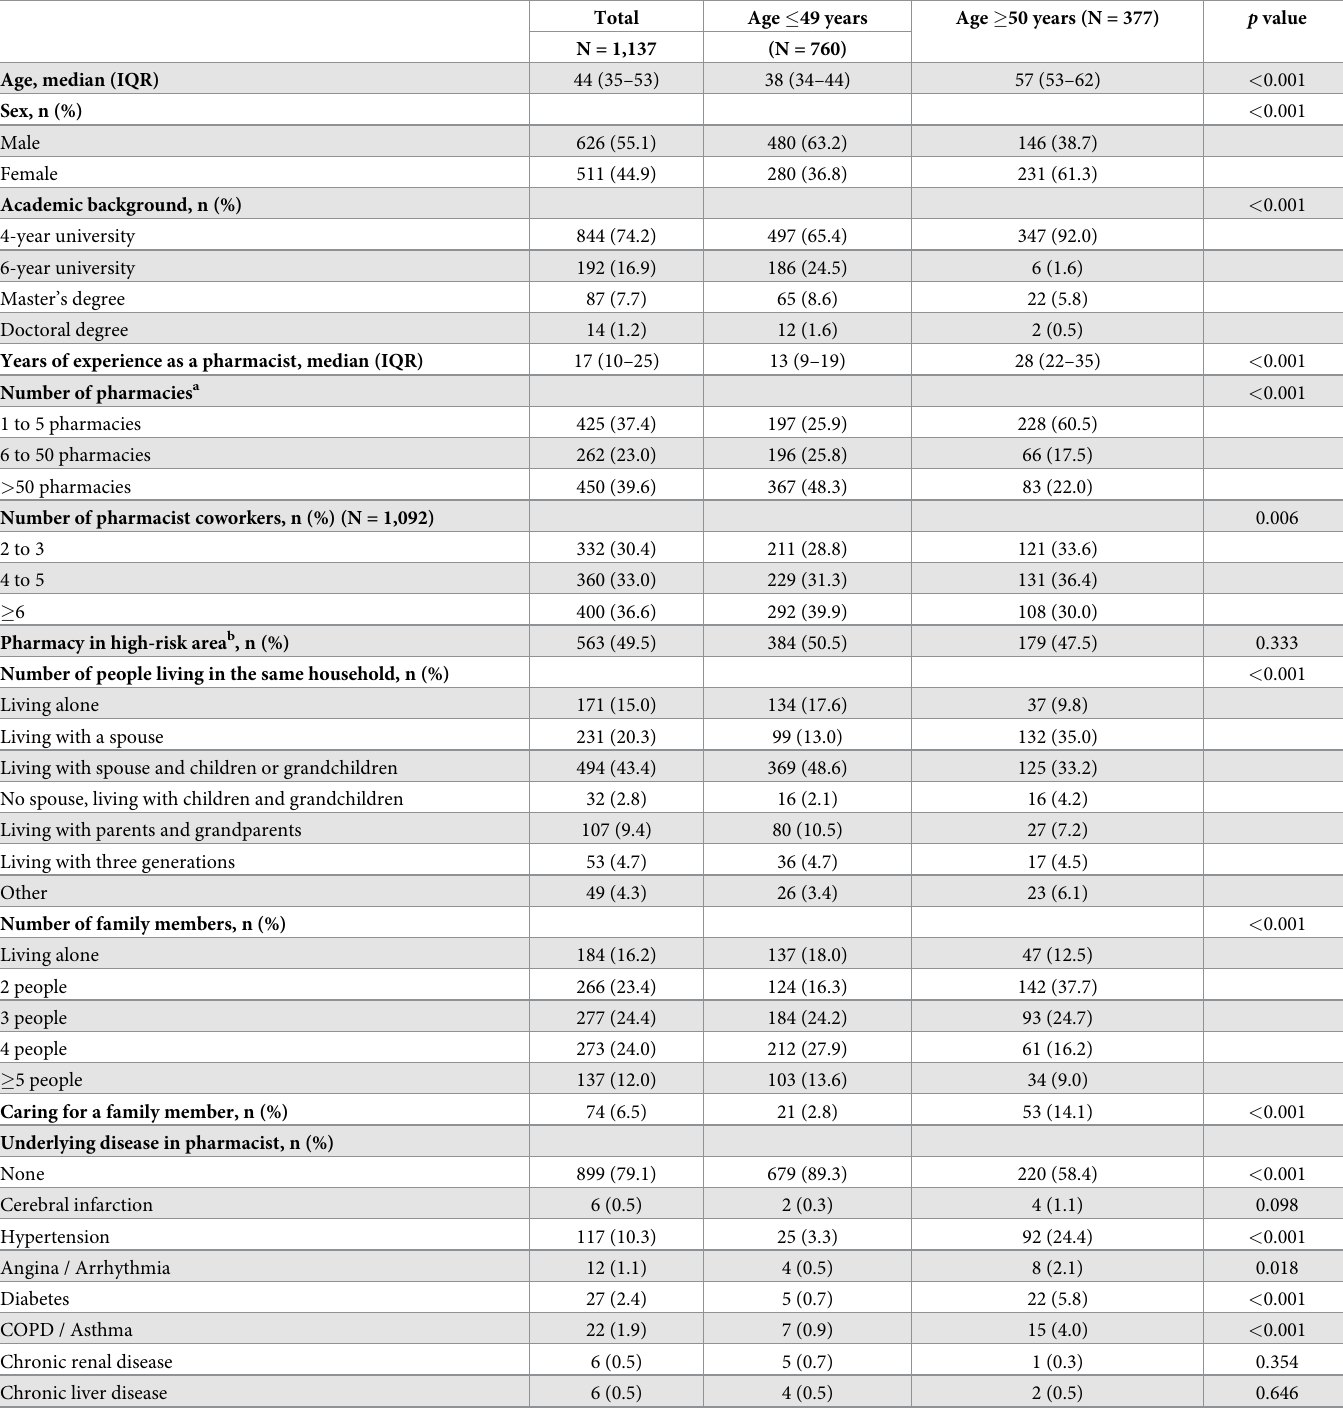
Table 1. Demographic data of HSP